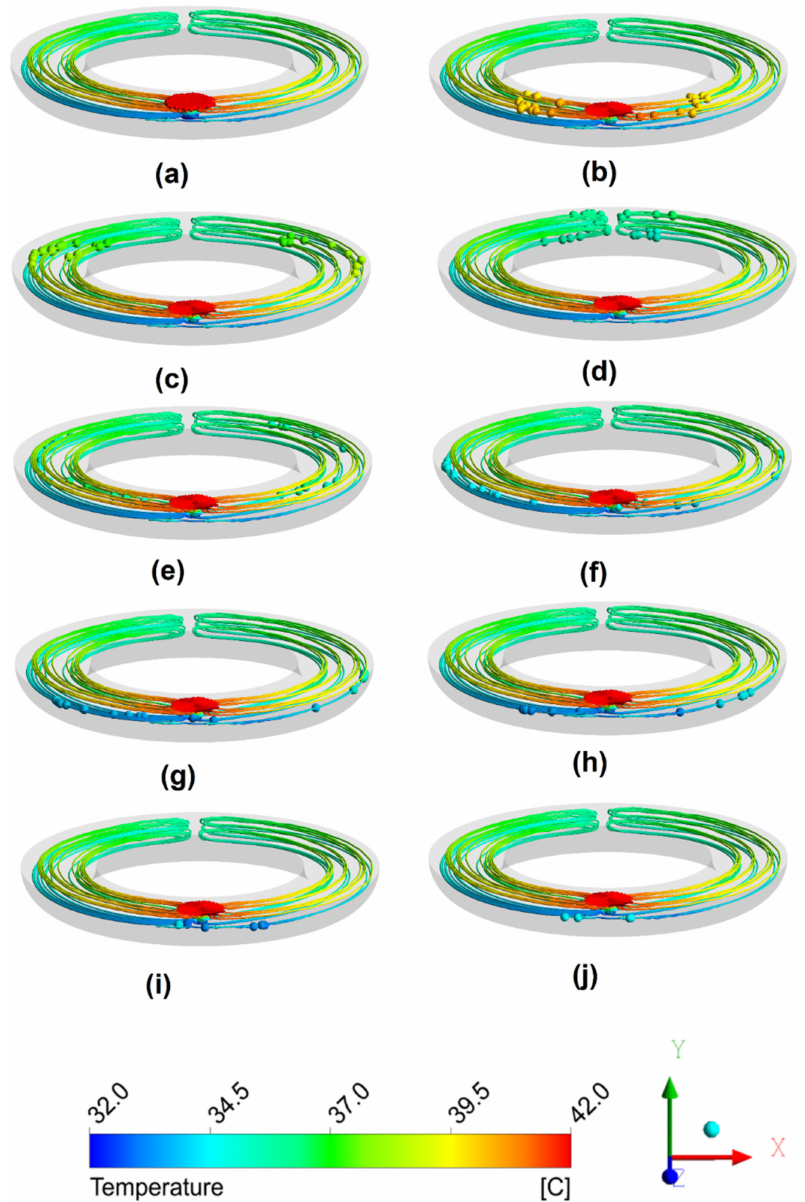
Figure 8. Streamlines in a torus emanating from the steam condensation zone, which is coloured with respect to temperature. The facets of the tunnelling phenomenon consist of ( a ) a heated plume rising from the region of the sparger, ( b , c ) expanding circumferentially, ( d ) sinking at the opposite ends of the sparger, and ( e – j ) returning to the sparger at a lower